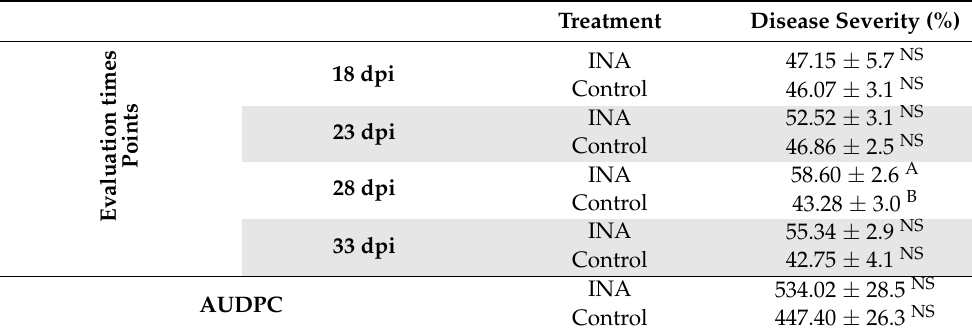
Table 2. The effect of 2,6-dichloroisonicotinic acid (INA) on Alternaria solani disease severity and progress on the tomato. Disease symptoms were evaluated using a 0–5 disease severity scale at 18, 23, 28, and 33 dpi. The AUDPC value measures the quantitative severity of the disease from 18 to 33 dpi observations.